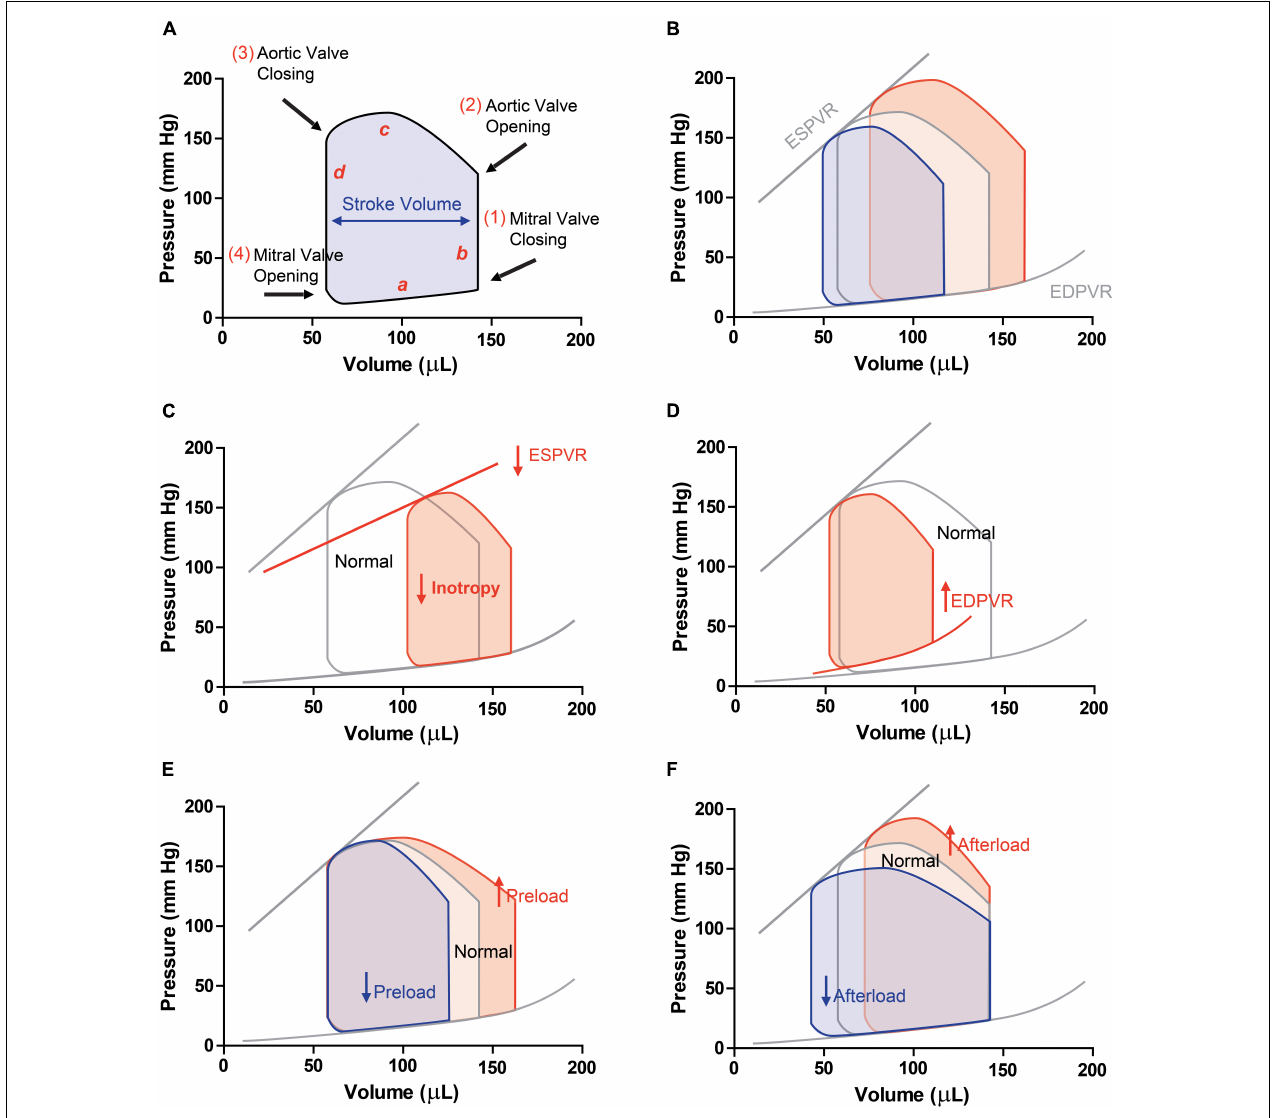
FIGURE 2 | Pressure-volume loops in (A) physiologic conditions (a, ventricular filling; b, isovolumetric contraction; c, ejection; d, isovolumic relaxation). (B) PV loops with different preloads are obtained by occluding the vena cava. This manoeuvre allows obtaining end-diastolic pressure-volume relationship (ESPVR, slope of the linear regression) and end-diastolic pressure-volume relationship (EDPVR, slope of the exponential curve), load-independent indexes of contractility and stiffness, respectively. PV-loops in a condition of (C) systolic dysfunction, and HFrEF, in which ESPVR, SV and EF decrease and (D) diastolic dysfunction and HFpEF, in which hypertrophy and increased stiffness are observed. Schematic PV-loops drawing of increased (red) or decreased (blue) preload (E) and afterload (F) .